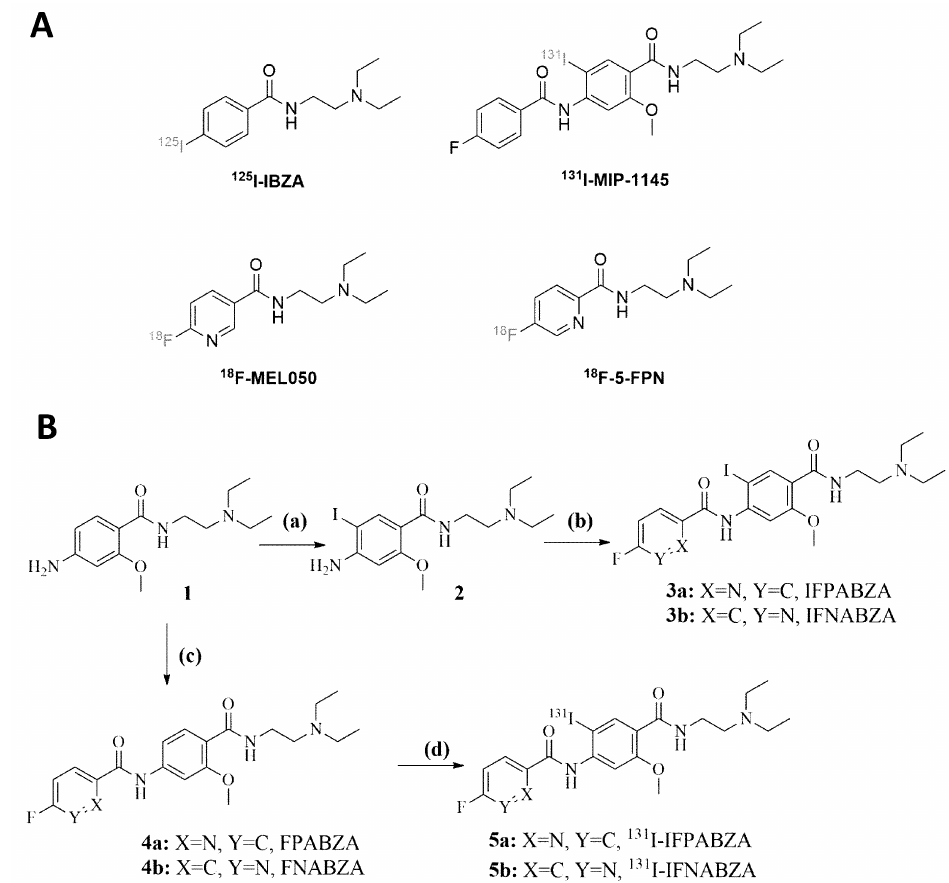
Figure 1. ( A ) The previously reported radiotracers for melanoma. ( B ) Synthetic scheme of non-radioactive ioflouropicolinamide-benzamide / iofluronicotinamide-benzamide (3a / 3b), precursor (4a / 4b), and 131 I-ioflouropicolinamide-benzamide / iofluronicotinamide-benzamide (5a / 5b). Reaction conditions: ( a ) CaCO 3 , and ICl, in MeOH / H 2 O, ambient temperature for 10 h; ( b ) EDC, HOBt, DIPEA, DEDA, and 5-fluoropyridine-2-carboxylic acid / 6-fluoronicotinic acid, in anhydrous THF, ambient temperature for 24 h; ( c ) 5-fluoropyridine-2-carboxylic acid / 6-fluoronicotinic acid, thionyl chloride, and K 2 CO 3 , in anhydrous THF, ambient temperature for 16 h; ( d ) Tl(TFA) 3 , and 131 I-NaI solution in 0.5% NaHCO 3 solution (pH 8.6~8.8), ambient temperature for 10 min.